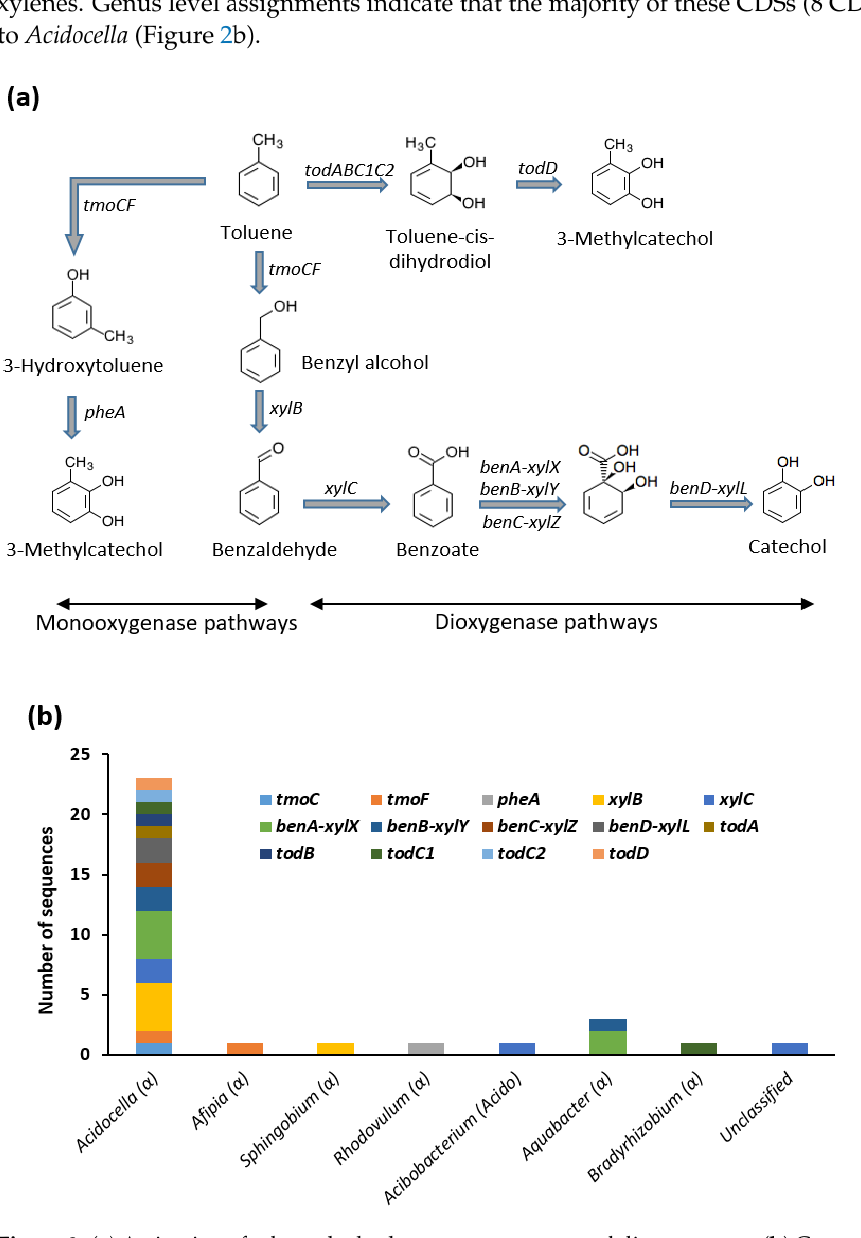
Figure 2. ( a ) Activation of toluene by both monooxygenases and dioxygenases. ( b ) Genus level assign- ment of the genes involved in toluene activation. Symbol (or letters) in parenthesis indicate the taxo- nomic class of each genus. tmoCF : toluene monooxygenases; pheA : phenol 2-monooxygenase; xylB : aryl alcohol dehydrogenase; xylC : benzaldehyde dehydrogenase; benA-xylX , benB-xylY and benC-xylZ : benzoate/toluate 1,2-dioxygenases; benD-xylL : dihydroxycyclohexadiene carboxylate dehydrogenase; todABC1C2 : benzene/toluene dioxygenases; todD : cis-1,2-dihydrobenzene-1,2-diol/chlorobenzene dihydrodiol